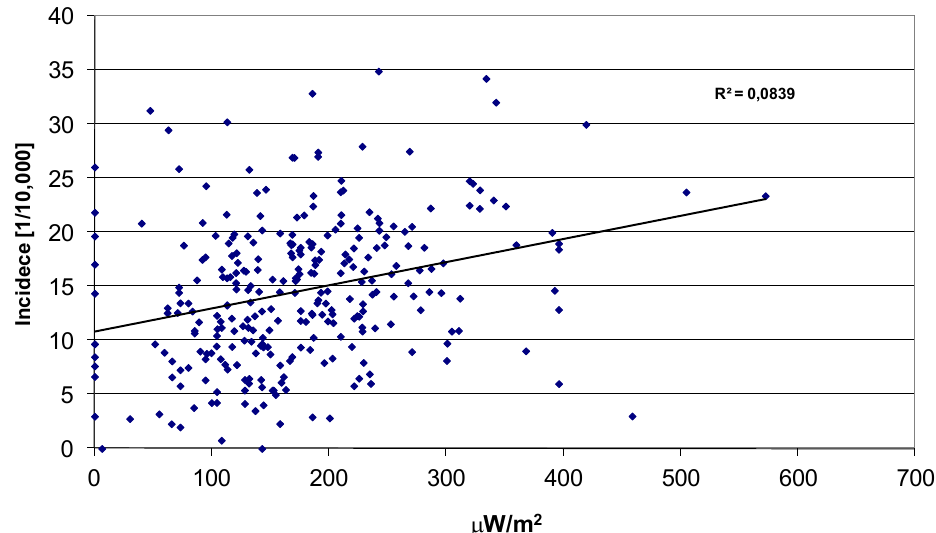
Figure 14. Calculated power density from main FM-transmitters vs . melanoma incidence in the 298 communities in